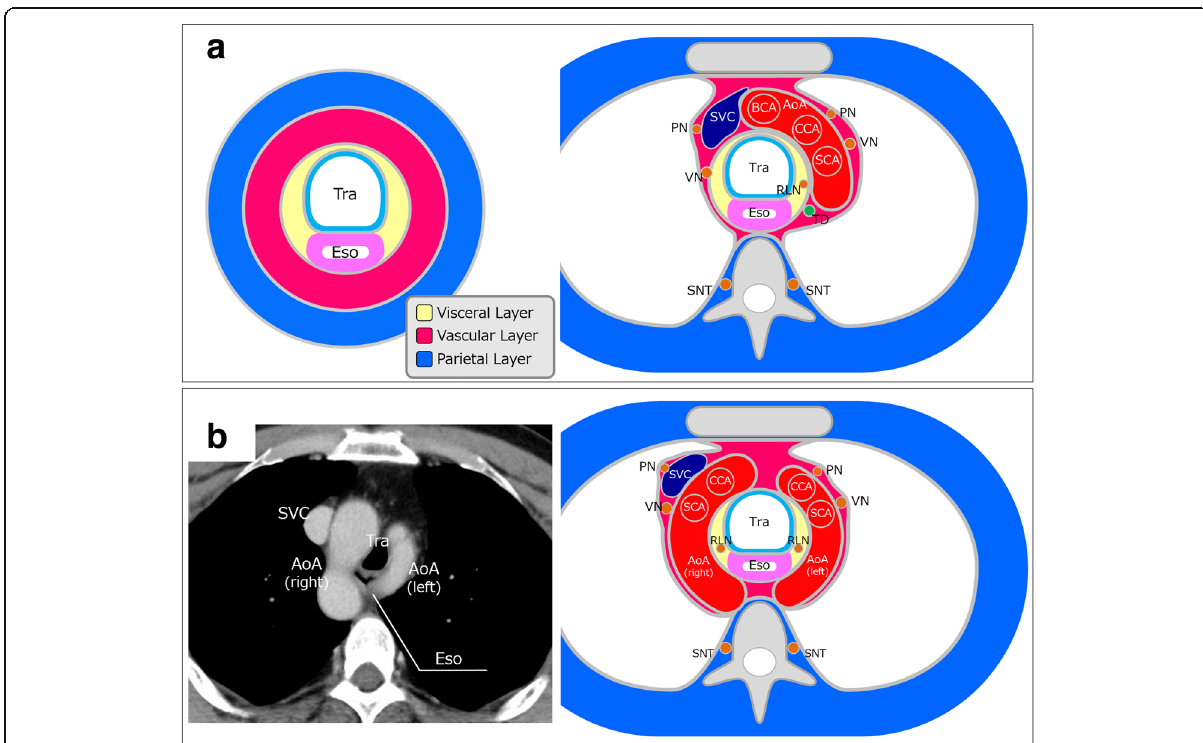
Fig. 6 a A concentric-structured model and surgical anatomy concerning the layer structure in the normal upper mediastinum. This anatomical model is based on human embryonic development. This is the essence of our surgical concept and practical anatomy. These figures are reproduced with permission from Fujiwara H, Kanamori J, Nakajima Y, Kawano T, Miura A, Fujita T, et al. An anatomical hypothesis: a “ concentric- structured model ” for the theoretical understanding of the surgical anatomy in the upper mediastinum required for esophagectomy with radical mediastinal lymph node dissection. Diseases of the esophagus: official journal of the International Society for Diseases of the Esophagus 2018 (Epub ahead of print) [12]. b The surgical anatomy of the upper mediastinum in patients with a double aortic arch, which we developed based on the concentric-structured model. We planned and performed the surgical procedure in this rare case while keeping in mind this theoretical surgical anatomy. AoA, aortic arch; BCA, brachiocephalic artery; CCA, common carotid artery; Eso, esophagus; PN, phrenic nerve; RLN, recurrent laryngeal nerve; SCA, subclavian artery; SNT, sympathetic nerve trunk; SVC, superior vena cava; TD, thoracic duct; Tra, trachea; VN, vagal